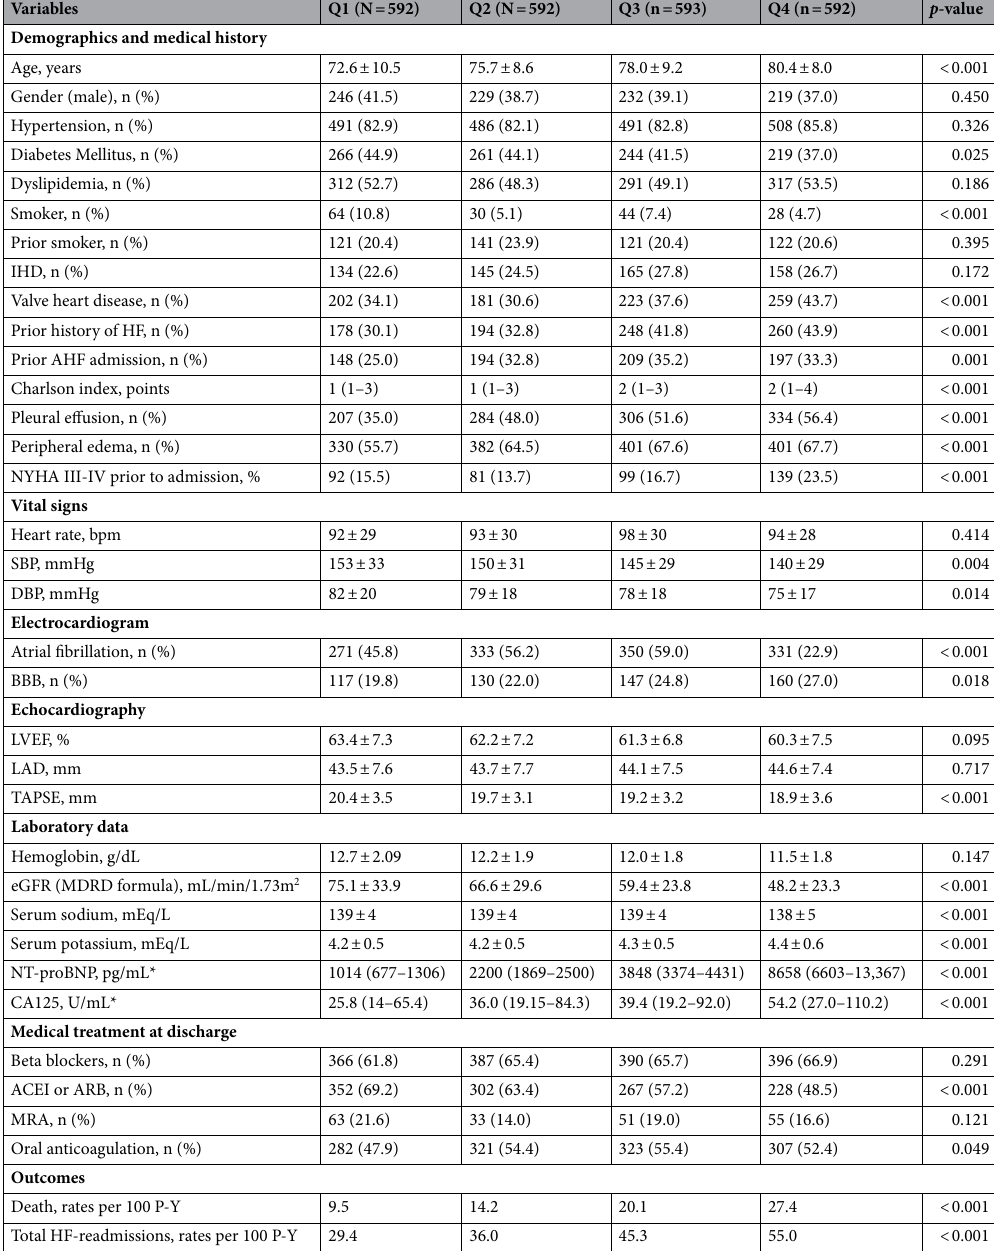
Table 2. Baseline characteristics across NT-proBNP quartiles. ACEI: angiotensin converting enzyme inhibitors; AHF: acute heart failure; ARB: angiotensin receptor blockers; BBB: bundle branch block;